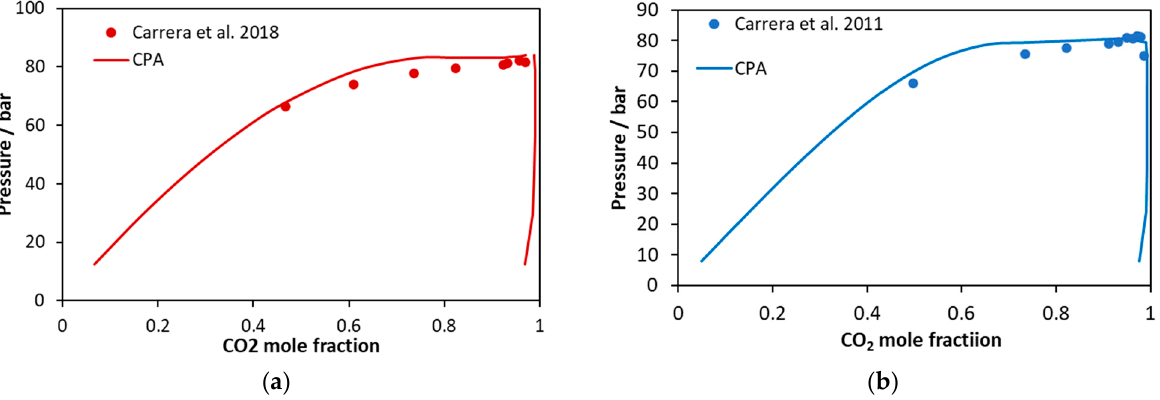
Figure 11. CO 2 mole fractions in liquid and vapor phases of ( a ) CO 2 –glycerol–methanol and ( b ) CO 2 – glycerol–ethanol ternary systems containing alcohol to glycerol ratio equal to 113. Experimental data [59,60] and CPA predictions using the binary interaction parameters of Table 6.